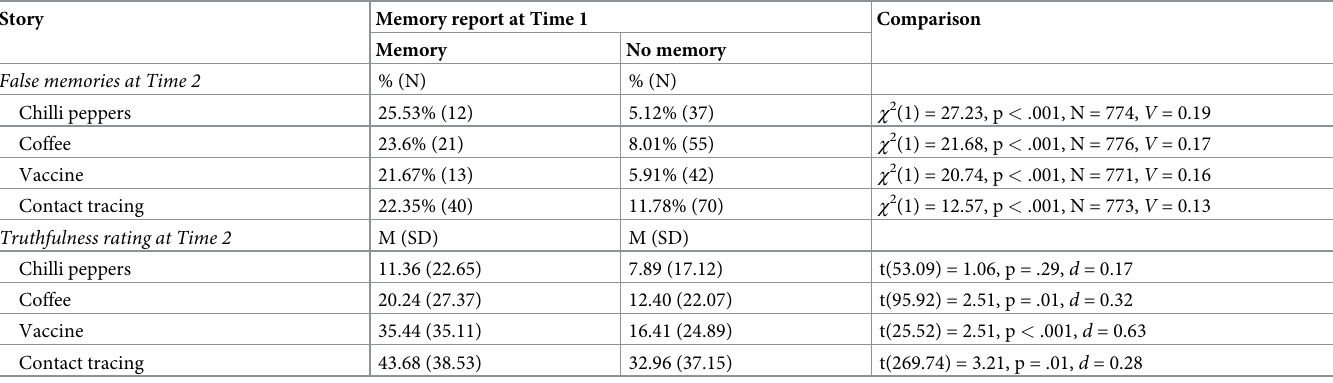
Table 2. False memories and truthfulness ratings at Time 2 for stories that were initially remembered or not remembered at Time